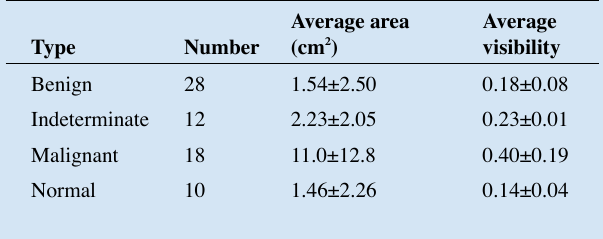
Table I. Average area and visibility of ROIs for the